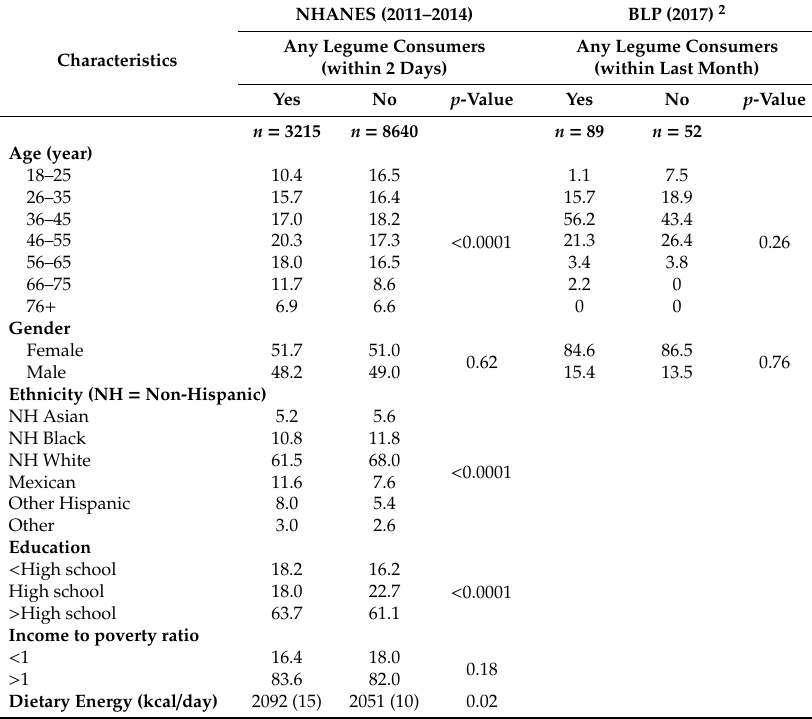
Table 1. Comparison between legume consumers and non-consumers: National Health and Nutrition Examination Survey (NHANES) and Beans, Lentils, Peas Nutrition Education Online Parent Survey (BLP) 1 .